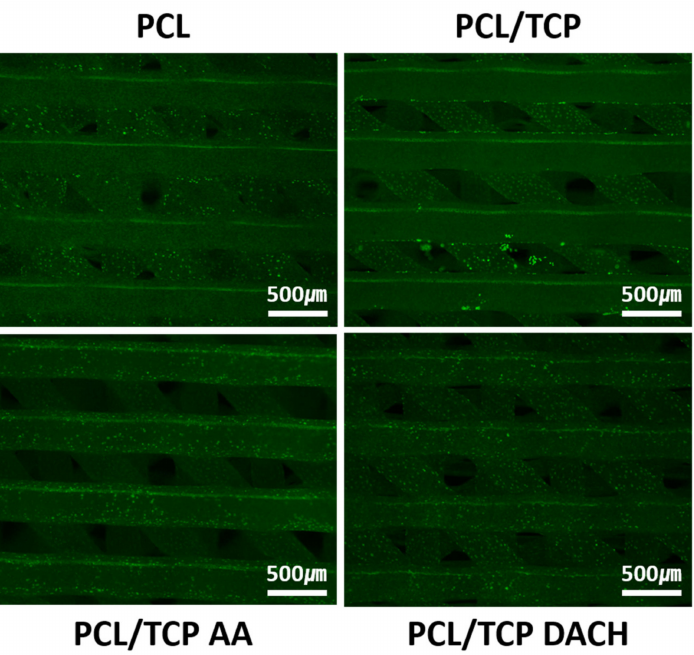
Figure 9. Live and Dead cell staining images of MC3T3-E1 cells cultured on the PCL scaffolds and PCL/ β -TCP scaffolds before and after allylamine and DACH plasma polymerization after 2 days. Live cells are indicated by green and dead cells are red (40 ×